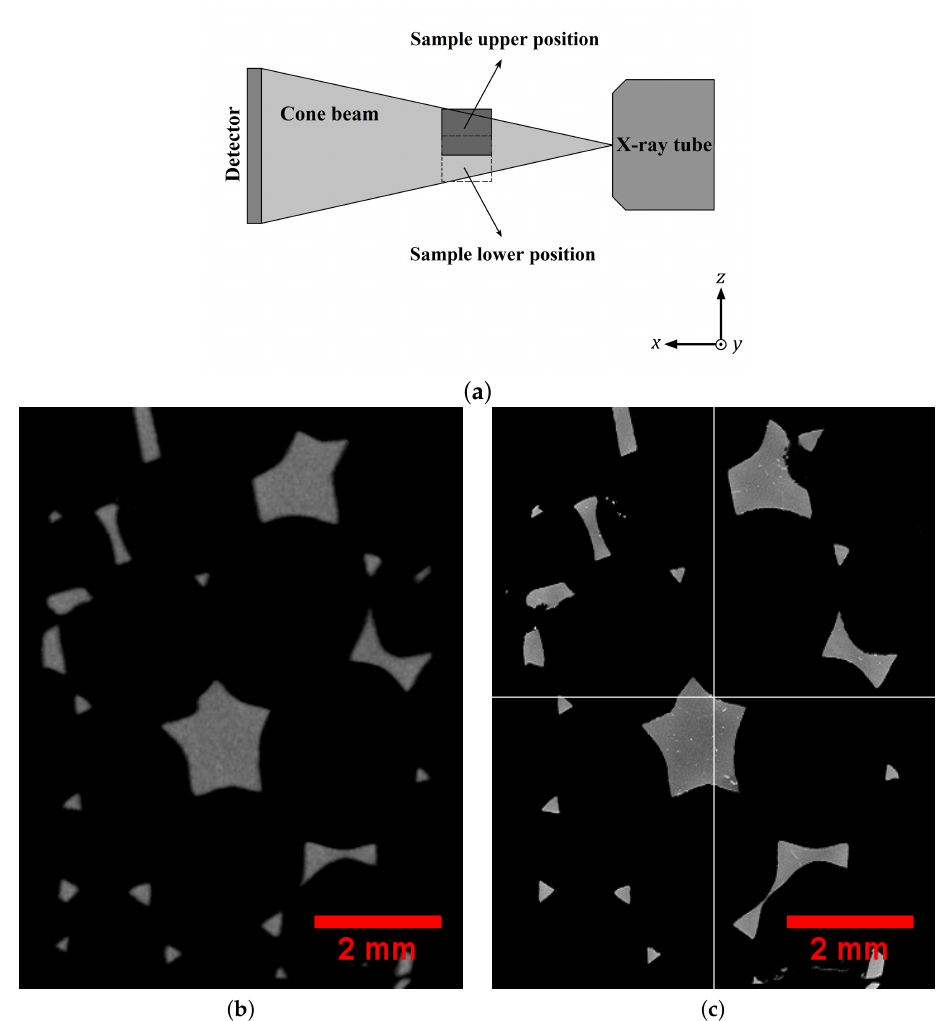
Figure 2. ( a ) Sketch of the stitching tomography setup. Tomography of entire geometry of the 20 PPI sample by: ( b ) global and ( c ) successive local procedure. In ( c ), the intermetallic particles are